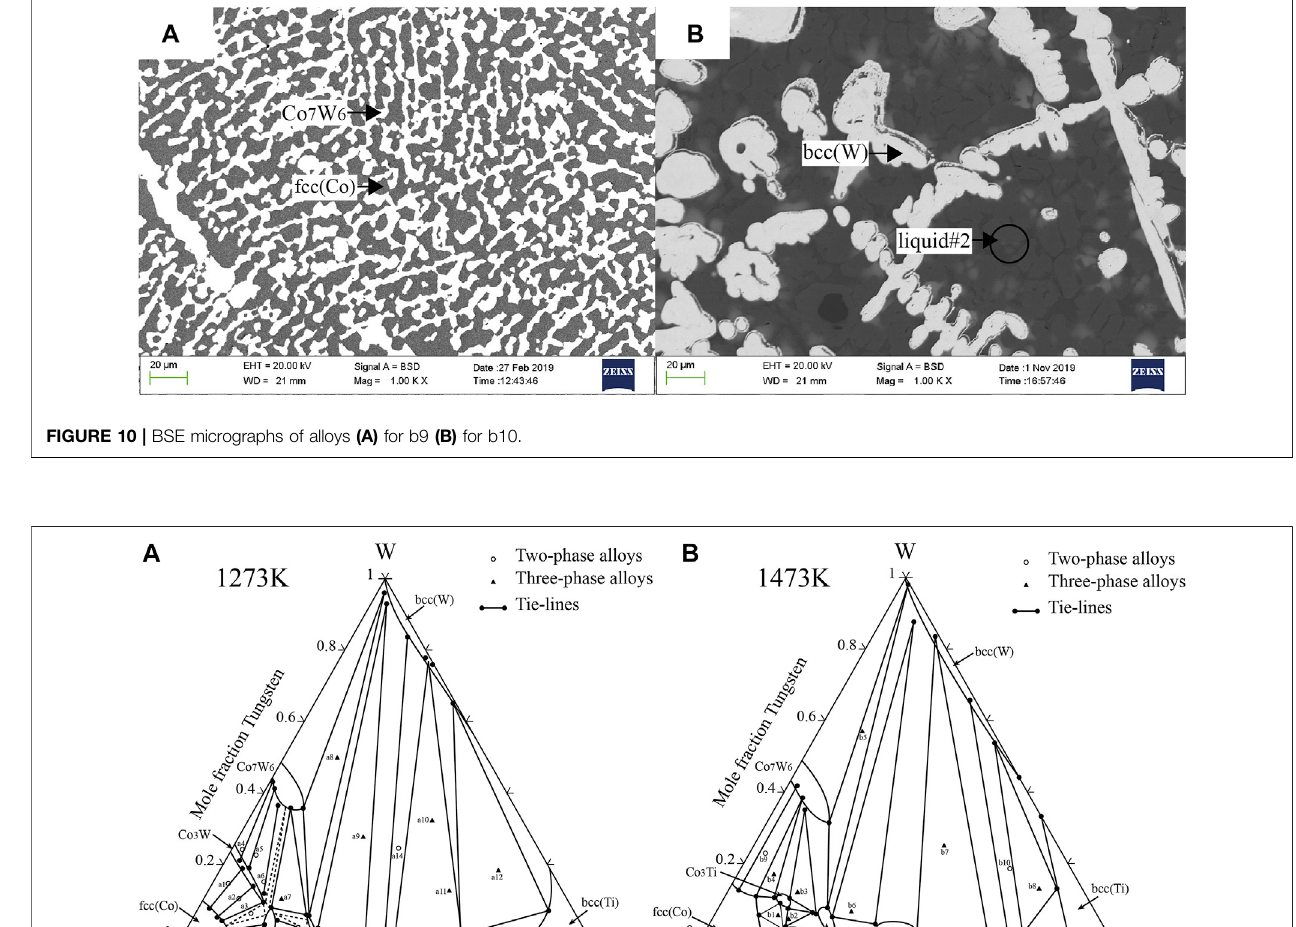
Figure 5C,D . According to the phase compositions and XRD result, alloy a12 was located in three-phase region bcc (Ti)+bcc(W)+CoTi 2 .